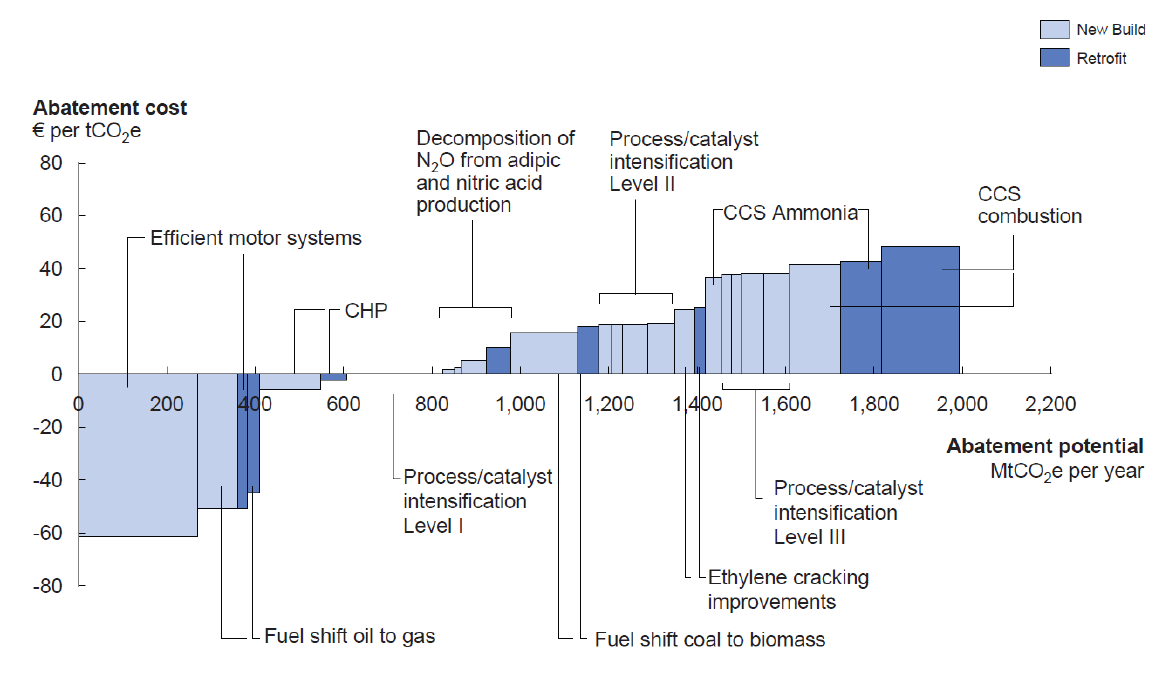
Figure 12. Global GHG abatement cost curve for the chemicals sector [38].